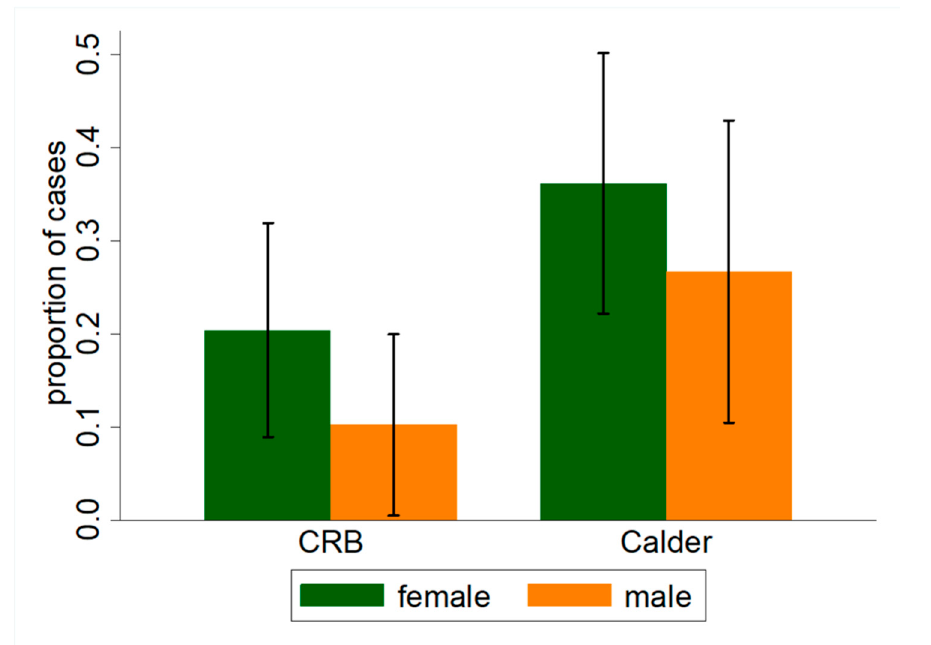
Figure 2. Proportion of individuals who reported worsening Dry Eye (DE) symptoms grouped by building (CRB = Clinical Research Building, control versus Calder Library, experimental) and sex. Table 3. Odds ratio of the presence and worsening of DE symptoms with respect to selected covariates. Selected